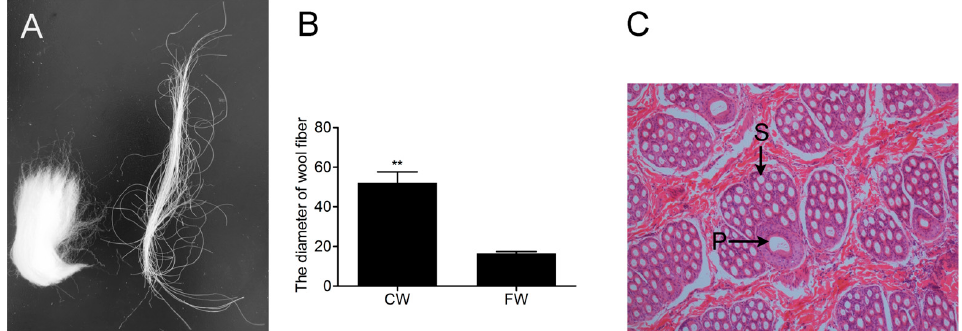
Figure 1. Comparison of coarse and fine wool and hair follicle traits of Wan strain Angora rabbits. ( A ) The appearance of coarse and fine wool. ( B ) The diameter of coarse and fine wool. ** p < 0.01. ( C ) Histological analysis of hair follicles. P means primary hair follicle; S means secondary hair follicle.